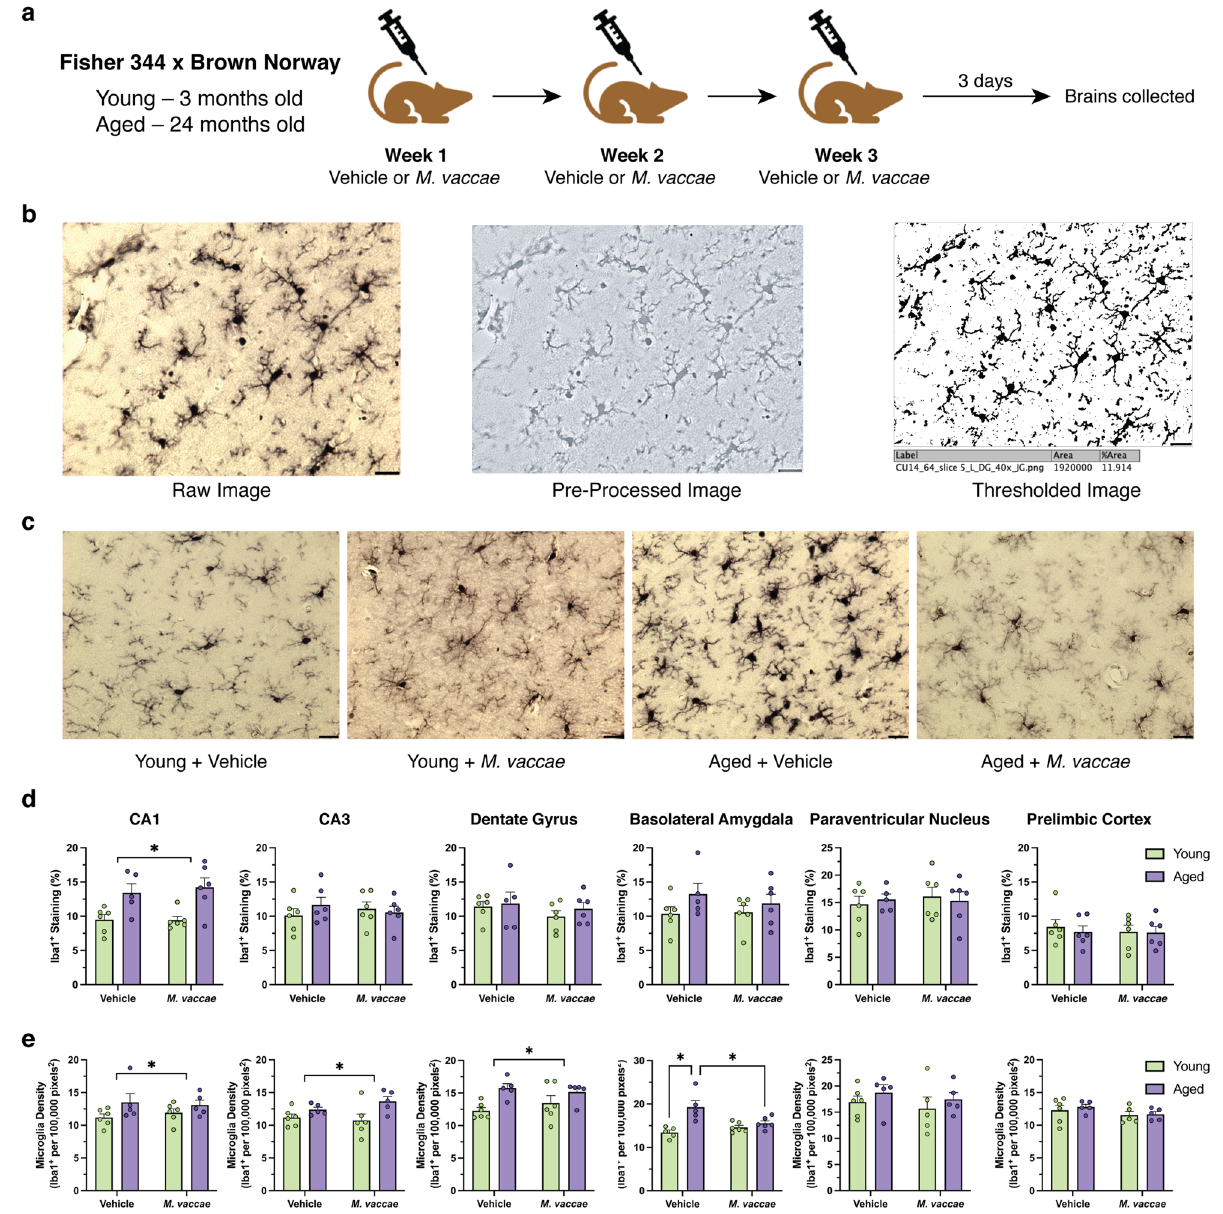
Figure 1. Microglial area fraction and density were elevated in the hippocampus and basolateral amygdala with aging, but only ameliorated by M. vaccae immunization in the amygdala. ( a ) Experimental timeline illustrating the timing of the M. vaccae immunizations. A dose of 100 μg of M. vaccae was administered subcutaneously once a week for three weeks. Three days after the final injection, brains were collected and perfused for subsequent microglia morphological analyses. ( b ) Methodology for performing area fraction analysis. Raw images from Iba1-stained slides were first pre-processed using a macro on FIJI to remove background noise and enhance clarity of microglia. This image was then thresholded and area fraction analysis performed. ( c ) Representative images from the CA3 subfield for each experimental group indicate differences in soma size and branching due to aging and M. vaccae immunization. ( d , e ) Area fraction and microglia density results for the basolateral amygdala, CA1, CA3, dentate gyrus, paraventricular nucleus, and prelimbic cortex. Iba1 + staining was the percent area containing the diaminobenzidine reaction product, and microglia density reflects normalized counts of the cell bodies in that brain region. The data are graphed as mean ± SEM; n = 5–6 rats/ group; scale bar = 20 μm; * p < 0.05 (Tukey’s post hoc test) or p < 0.05, main effect of